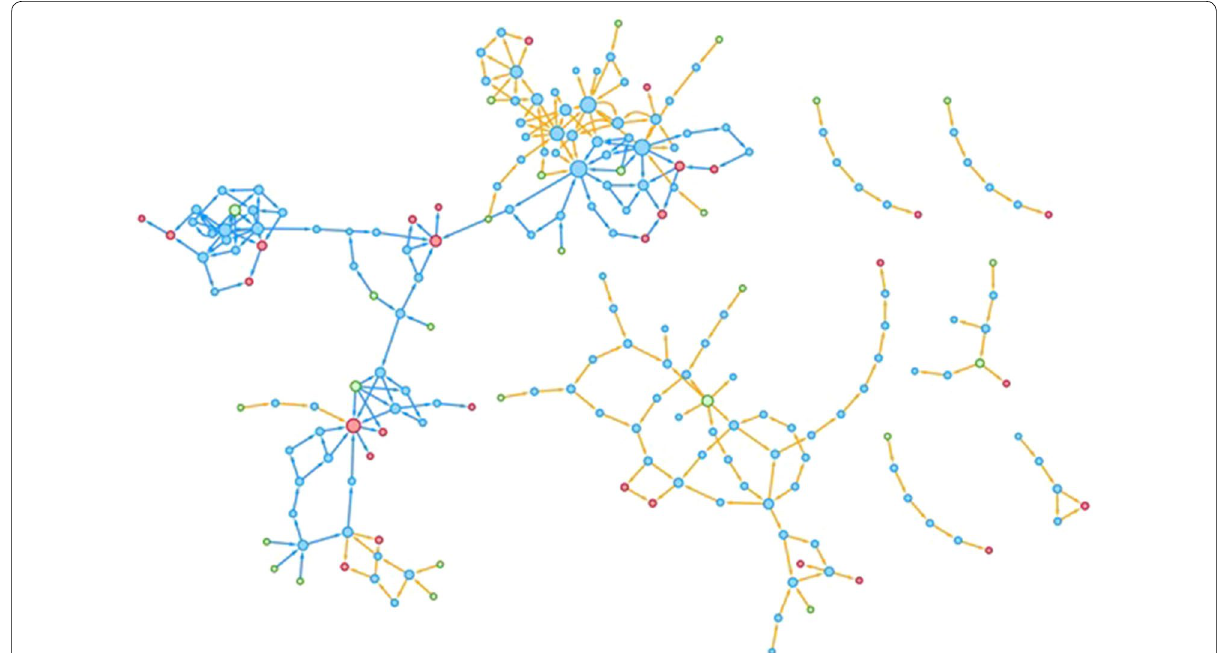
Fig. 5 Assembly of AOP networks showing all AOPs relevant to human (orange) and eco‑neurotoxicity (blue) that are available in the AOP‑Wiki (https ://aopwi ki.org; Accession date: April 30, 2018; Eco‑neurotoxicity AOP numbers 16, 77, 78, 79, 80, 82, 87, 88, 89, 90, 91, 93, 94, 95, 97, 98, 99, 113, 160, 161, 178, 195, 197, 203, 204; Human neurotoxicity AOP numbers 3, 8, 10, 12, 13, 17, 26, 42, 48, 54, 73, 104, 112, 126, 134, 152, 164, 170, 214, 215, 221, 222, 223, 224, 225, 226, 230, 231, 233, 234, 235, 236; Network constructed using Cytoscape 3.6.1). Nodes in the network are key events (KEs), and edges represent key event relationships (KERs). Molecular initiating events are displayed in green, adverse outcomes in red. All other KEs are depicted in blue. Node size represents node degree (the total number of KERs connecting the KE to the network, [334]). KERs in blue are part of eco‑neurotoxicity AOPs and correspond to Fig. 4, KERs in orange are part of human neurotoxicity AOPs. The AOP network does not make any inference about the scientific validity of the underlying AOPs, nor can it at this stage be used for in‑depth biological interpretation or regulatory